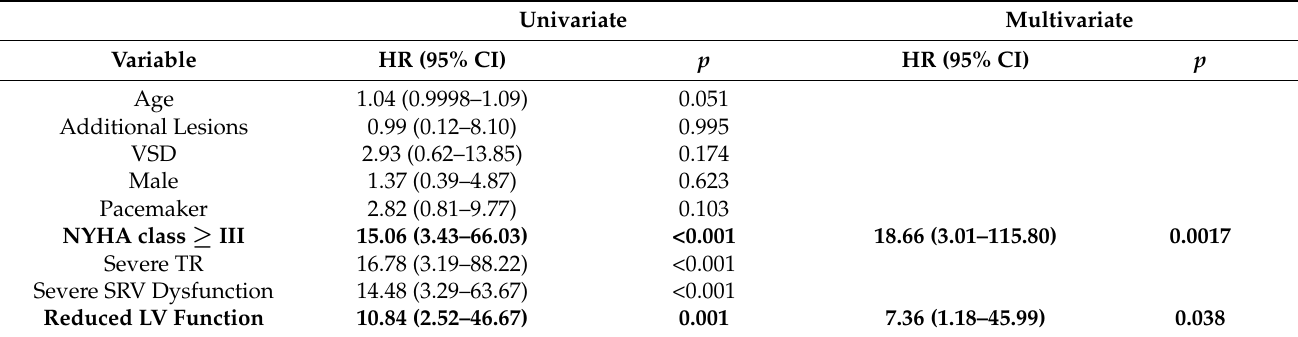
Table 3. Univariate and multivariate analysis of predictors for all-cause mortality. Univariate Multivariate